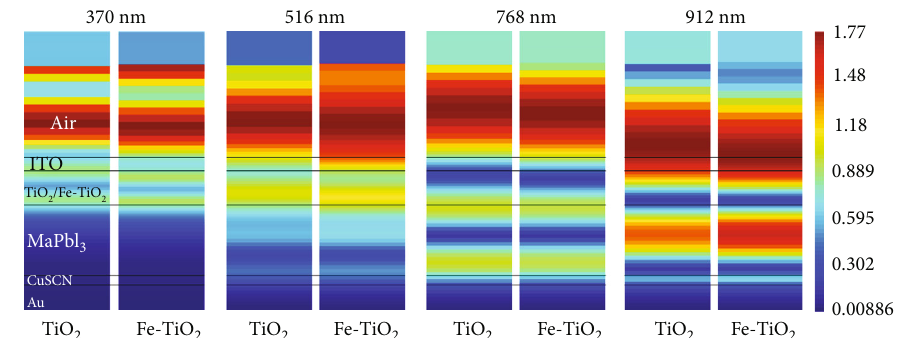
Figure 4: Comparison of E - fi eld pro fi le for PSC structure with ETL TiO